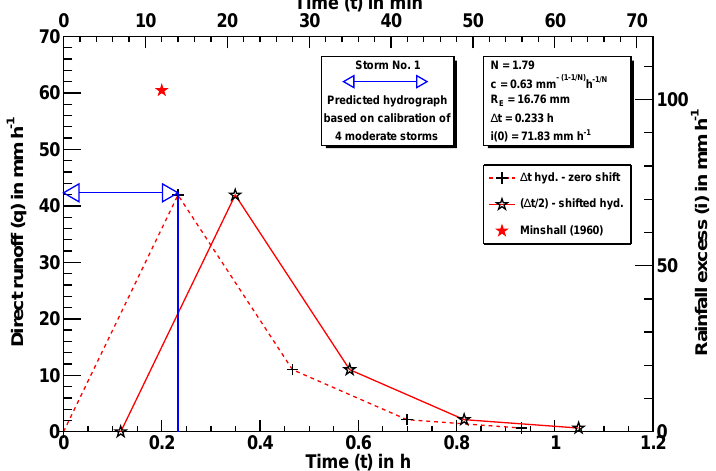
Fig. 7b. Same as Fig. 7a, except the 1t hydrograph is computed using the inverse Bakhmeteff function method of